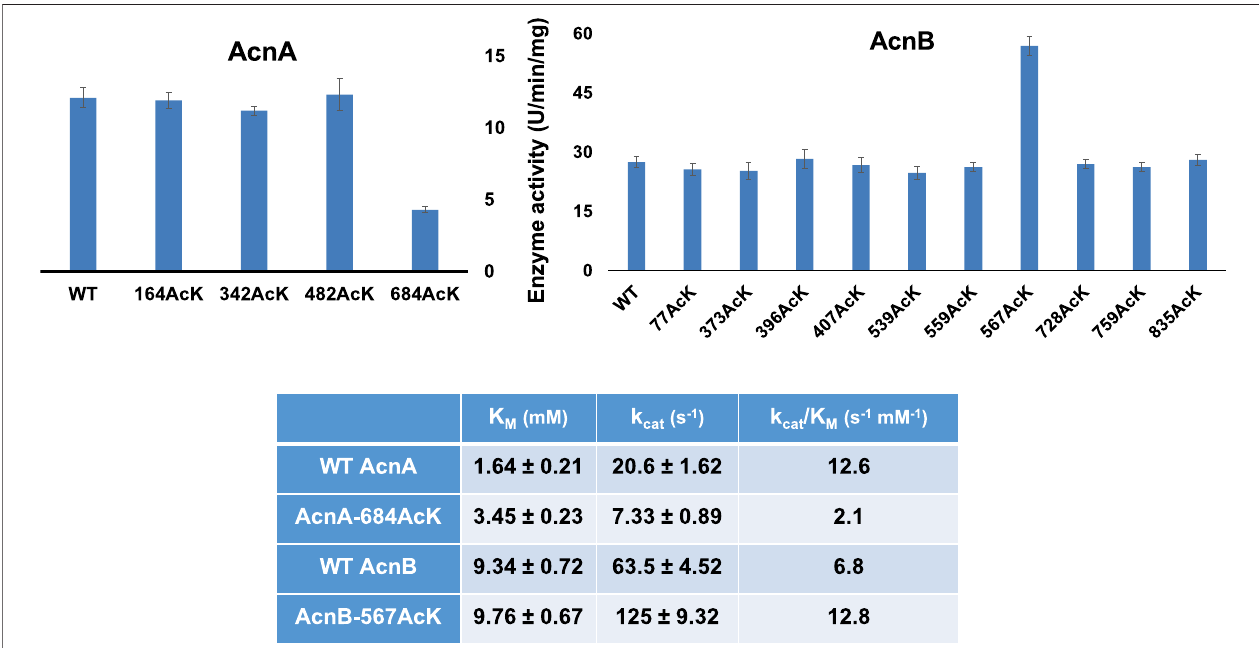
FIGURE1| TheenzymeactivitiesandkineticanalysesofAcnA,AcnBandtheiracetylatedvariants.The (A) isenzymeactivitiesmeasuredbythecommercialkitwith 50 mM citrate as the substrate concentration. The (B) is the steady-state kinetic parameters. Kinetic parameters were calculated by non-liner regression with software Gra fi t.Mean values and standard deviations were calculated based on threereplicates.The Student ’ s ttest wasused toanalyze the signi fi cance ofdifferences between activities of each acetylated variant and the corresponding WT enzyme.